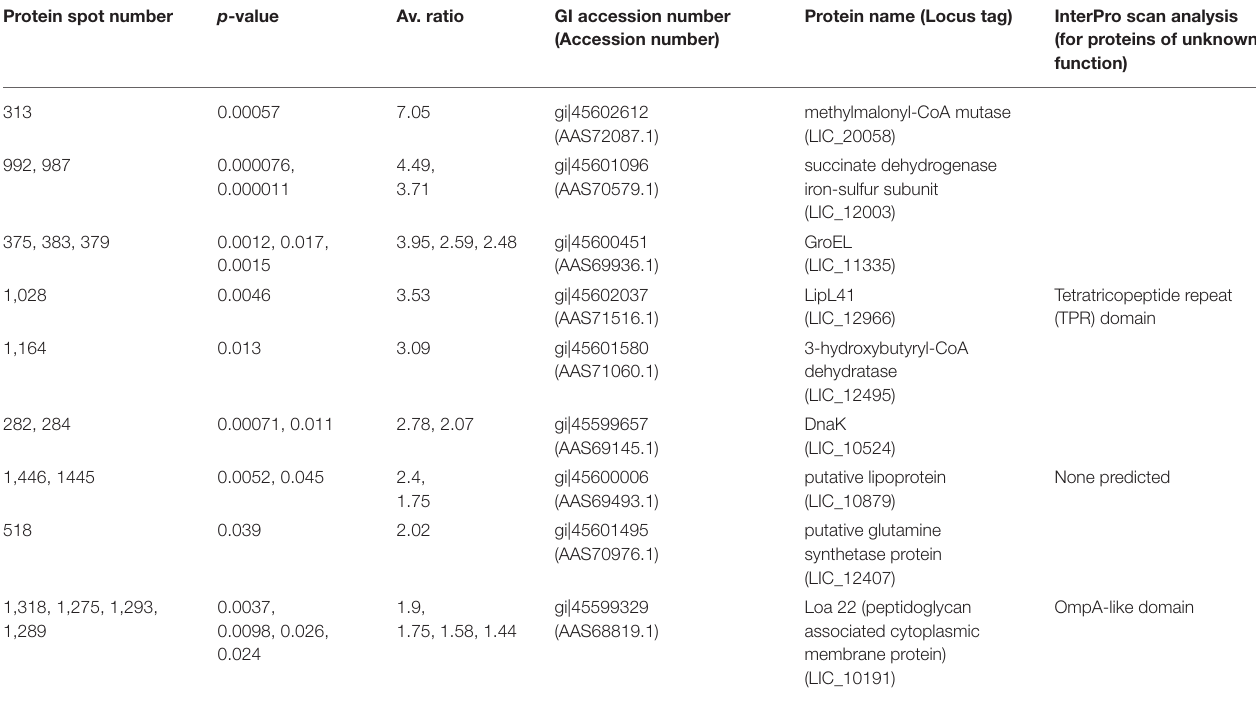
TABLE 2 | Proteins more abundant ( p < 0.05, fold > 1.25) in DMC-cultivated leptospires compared to IV30-cultivated leptospires. Protein spot number p -value Av. ratio GI accession number